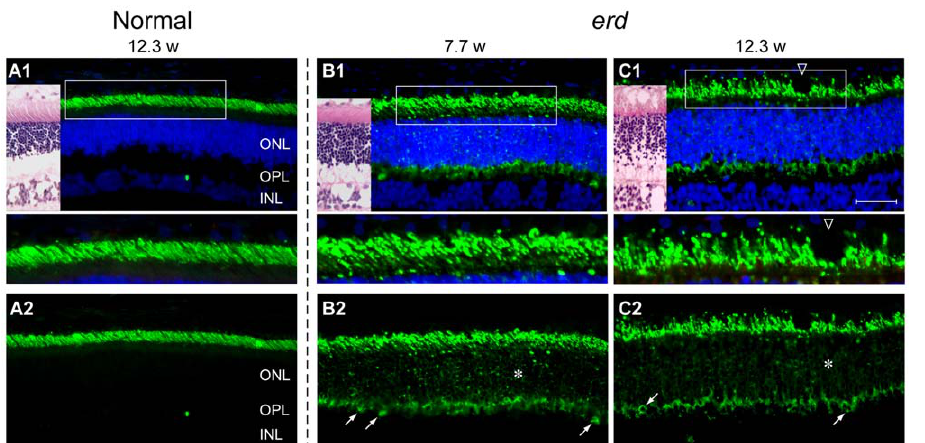
Figure 2. Early rod abnormalities in erd . Immunofluorescence labeling with anti-rod opsin antibody (green) shown with (A1, B1, C1) and without (A2, B2, C2) the blue DAPI nuclear stain in normal (A1, A2) and erd -mutant (B1, B2, C1, C2) retinas of different ages (weeks=w). (A1, B1, C1) Images of H&E stained adjacent cryosections are included for illustration. The boxed areas in the first row are presented at higher magnification in the panels below. (A1, A2) In normals, rod opsin labeling is restricted to the well oriented outer segments. (B1, B2, C1, C2) Rod outer segments are variable in length and irregular in erd , and opsin delocalizes to the inner segments, ONL (*) and OPL synaptic terminals (oblique arrows). The rod opsin delocalization is visualized best without DAPI. ONL=outer nuclear layer, OPL=outer plexiform layer, INL=inner nuclear layer. Scale bar 40 m m for principal panels.